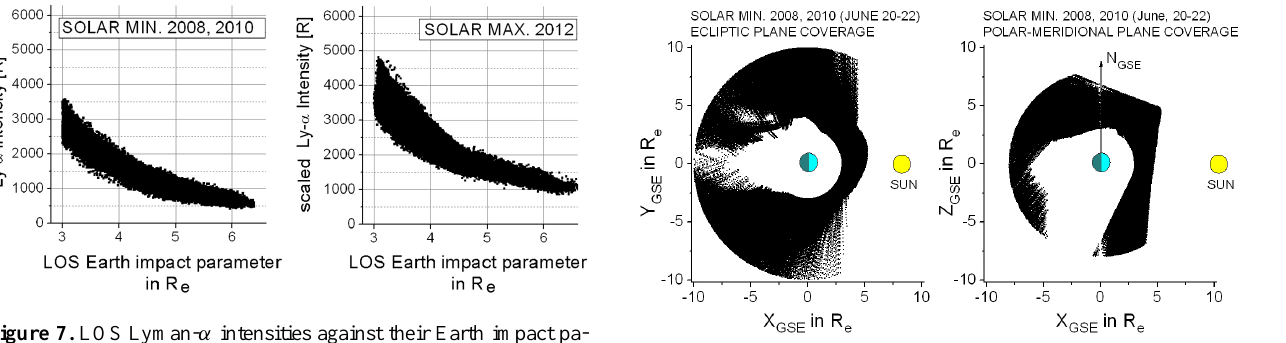
Figure 8. Observational LOS coverage of the solar minimum data set: LOS intersections with (left) the ecliptic plane (within an an- gular extent of θ ± 25 ◦ around the ecliptic plane) and (right) the polar-meridional plane (within an angular extent of φ ± 25 ◦ around the polar-meridional plane).